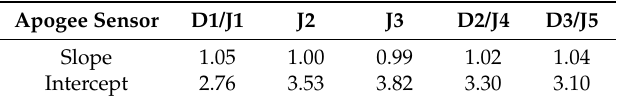
Table 3. Correction for Apogee infrared radiometer equations based on y = mx + b , where y is